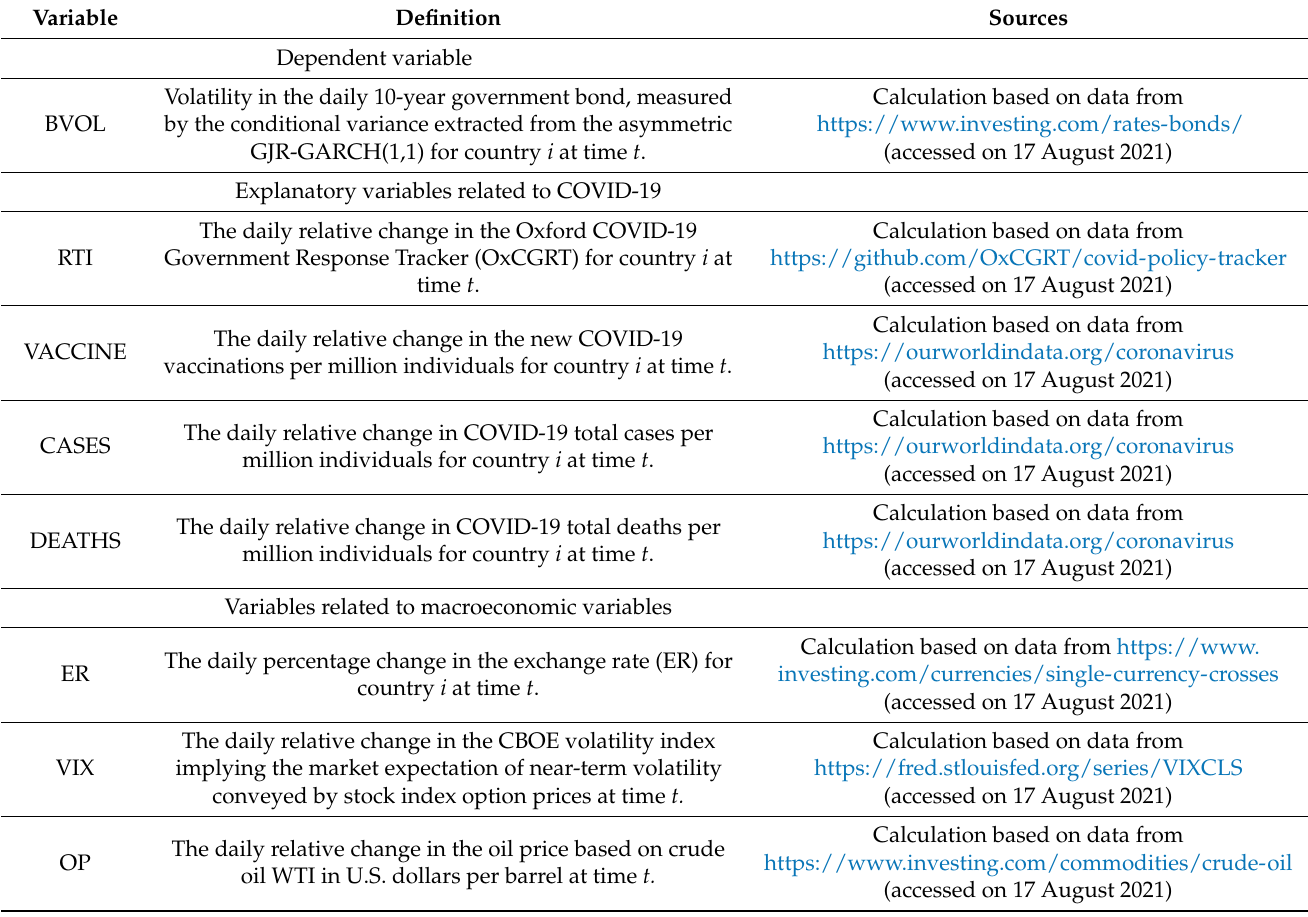
Table 1. Variable